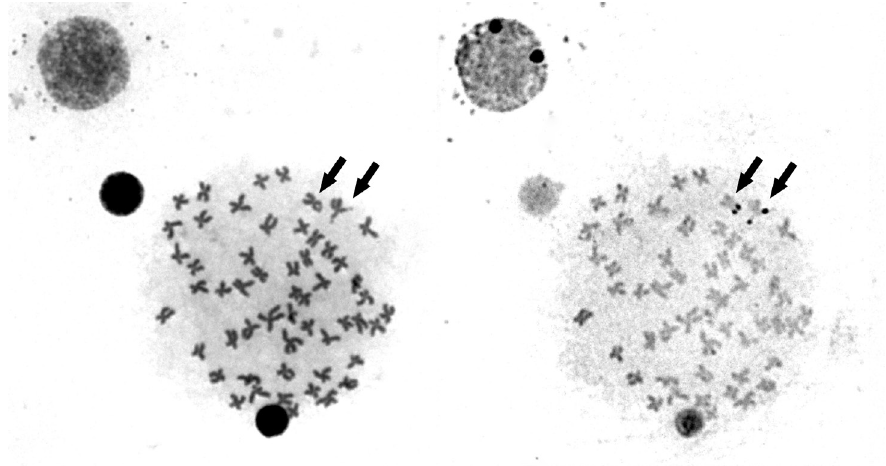
Figure 2. Ag-NOR staining on metaphase chromosomes of Ichthyoelephas humeralis after Giemsa staining (arrows show the NOR-bearing